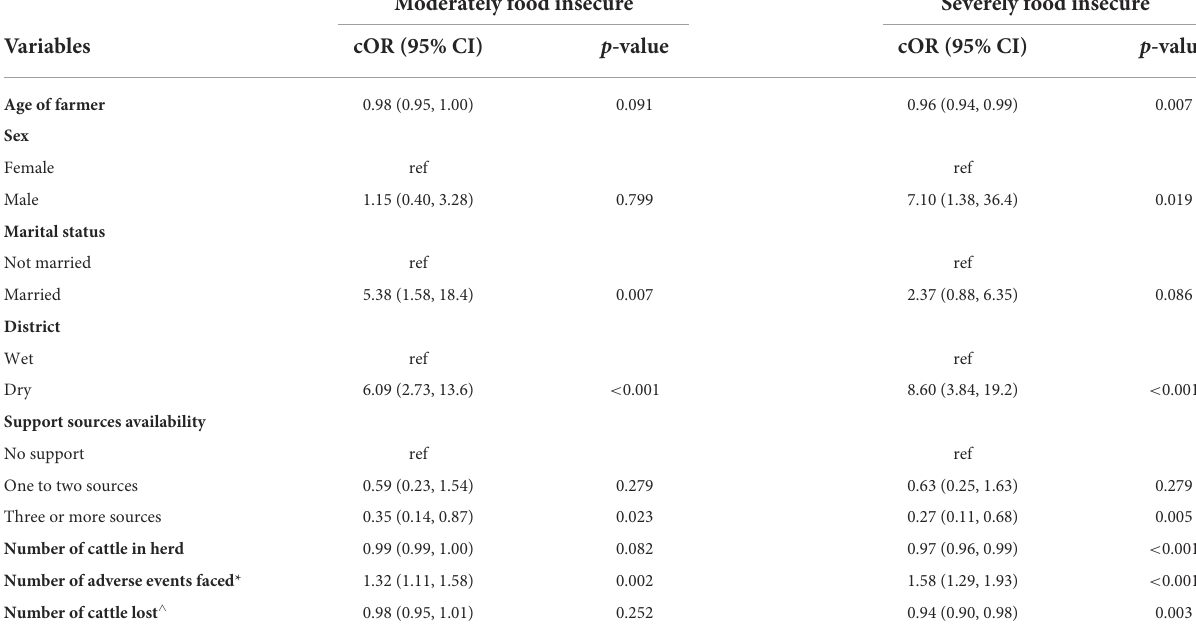
TABLE 4 Univariable analysis of food security level predictors of cattle farming households in